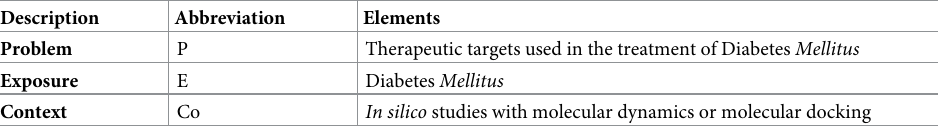
Co In silico studies with molecular dynamics or molecular docking PECo (P, problem; E, exposure; Co,